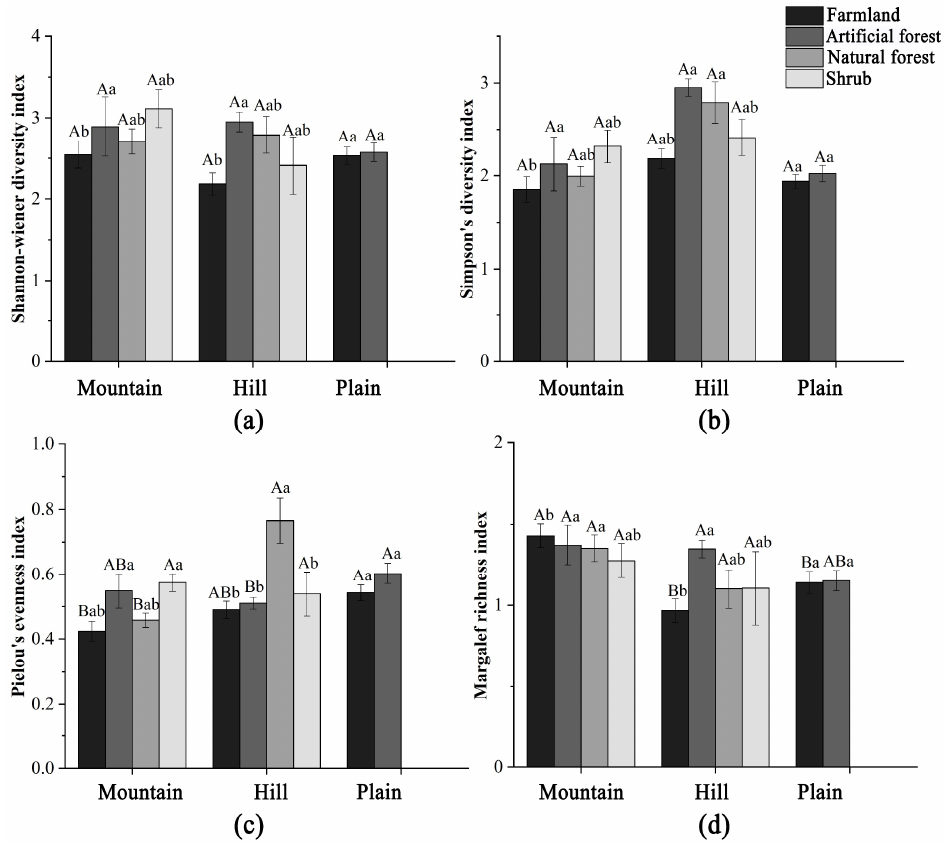
Figure 4. Effects of landform and habitat type on soil fauna diversity. ( a ) Shannon-Wiener diversity indices under different geomorphic and habitat conditions; ( b ) Simpson’s diversity indices under different geomorphic and habitat conditions; ( c ) Pielou’s evenness indices under different geomorphic and habitat conditions; ( d ) Margalef richness indices under different geomorphic and habitat conditions. Error bars in the figure are standard deviations. The lowercase a and b on top of the columns represent the results of variance analysis in different habitats of the same landform. Different letters represent significant differences between the two ( p < 0.05). The upper-case A and B on top of the columns represent the results of variance analysis under different geomorphic conditions of the same habitat, and different letters represent significant differences between them ( p < 0.05).